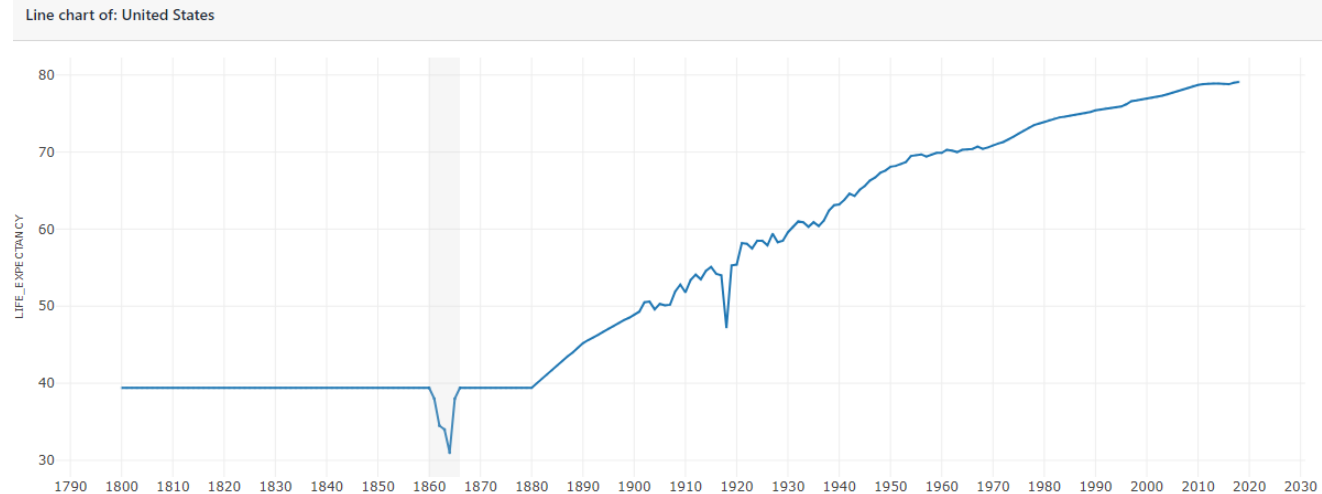
Figure 4. Life expectancy line chart of the United States. Two noticeable valleys are observed between 1860 and 1866 and between 1917 and 1919. The gray area represents the user